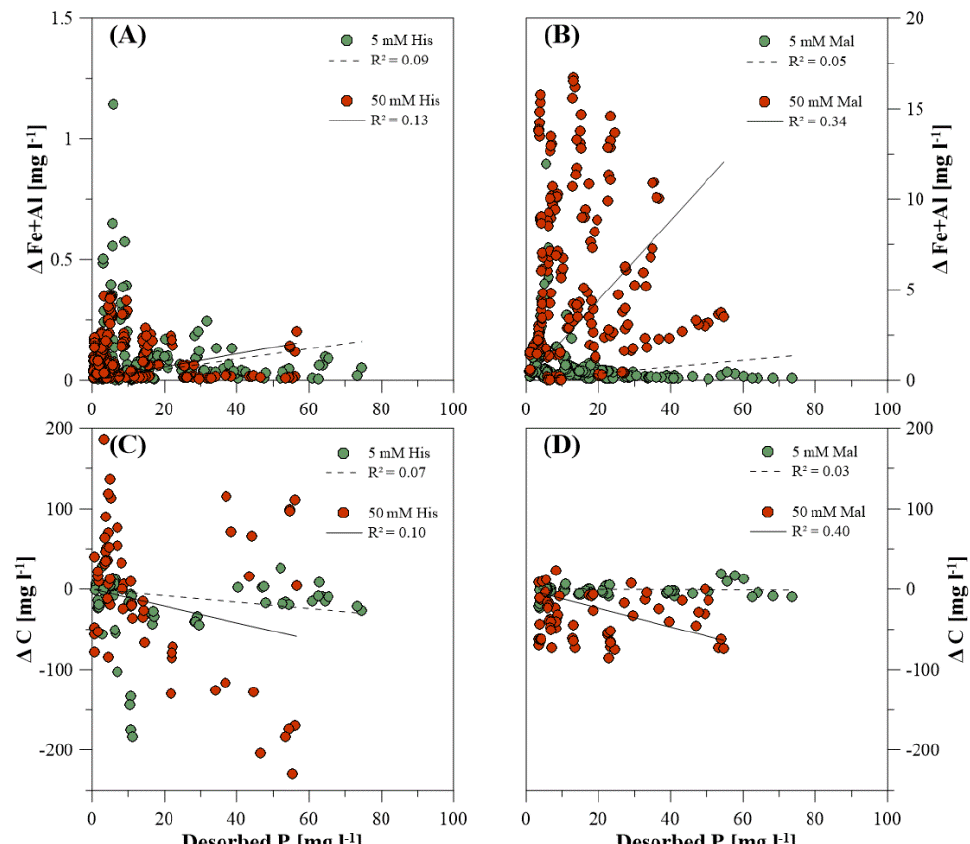
Figure 4. Correlation between desorbed P and the change of ( A ) dissolved total Fe + Al for histidine, ( B ) dissolved total Fe + Al for malic acid, ( C ) dissolved total C for histidine, and ( D ) dissolved total C for malic acid in the sample solution for all hydroxides and each desorption time